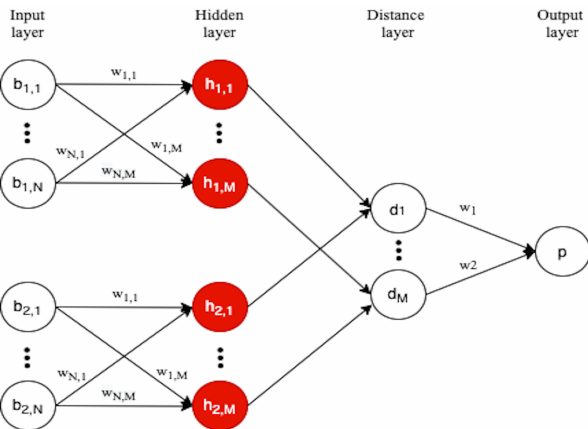
Figure 1. A simple Siamese neural network architecture.